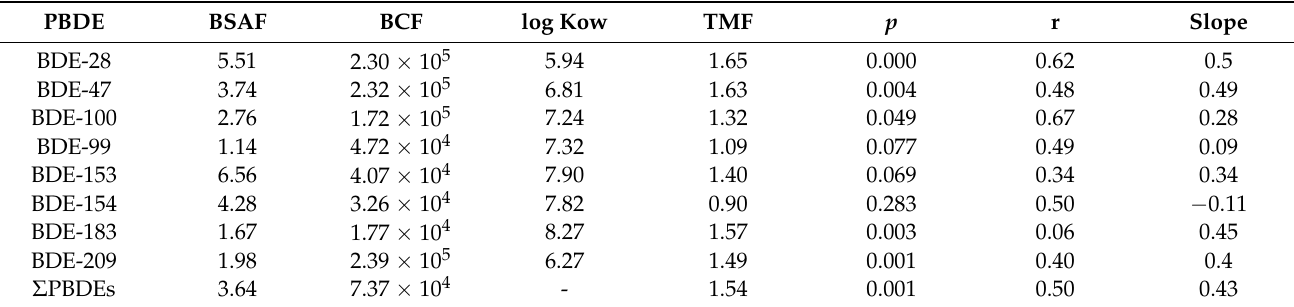
Table 2. BCF, BSAF, log Kow, slope and p -value of the slope of the regression analysis between the natural logarithm of concentration and TLs, and TMFs for PBDE congeners in aquatic organisms collected from typical shallow lakes. Log Kow of PBDEs were referenced from the U.S.